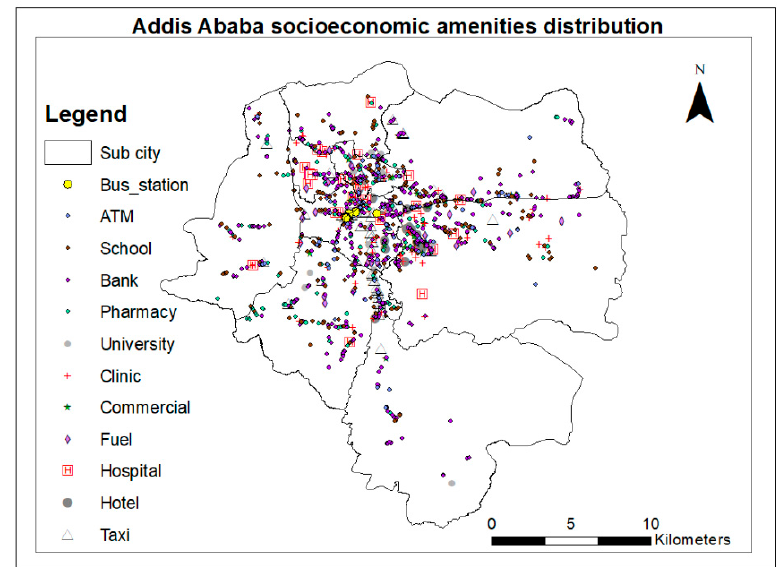
Figure 12. Assorted urban socio-economic amenities (health, education, transport, finance, and commercial) distribution in Addis Ababa.